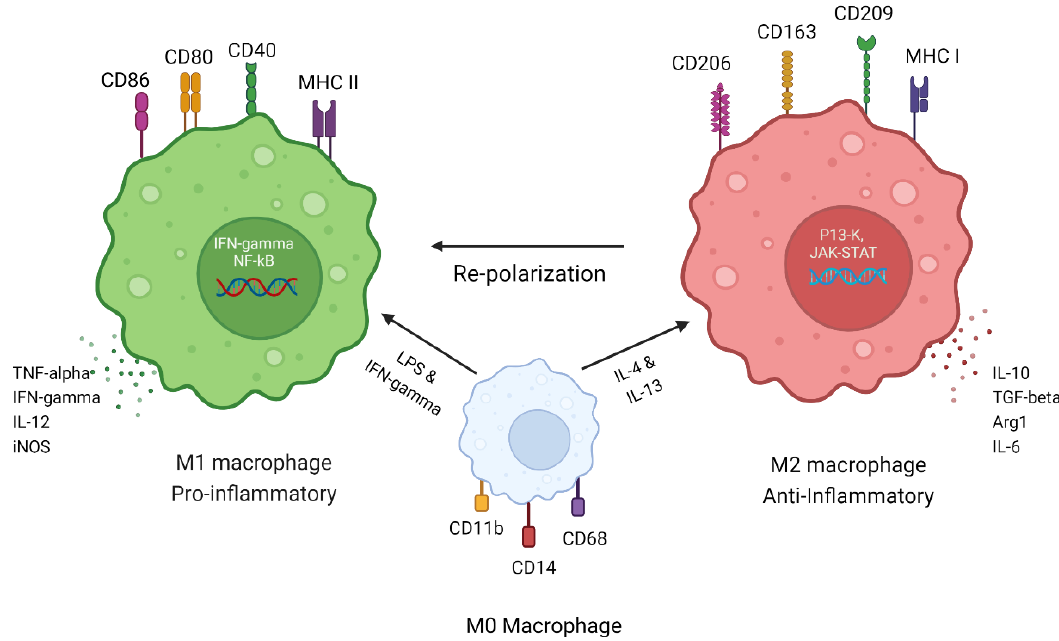
Figure 1. Macrophage plasticity. Macrophage states under different stimuli. Monocyte-derived M0 macrophages have CD11b, CD14, and CD68 as their surface markers. The stimulation of M0 macrophages with LPS and IFN-gamma converts them to pro-inflammatory M1 macrophages, which express cell surface receptors such as CD86, CD80, CD40, and MHC class II. M1 macrophage secretes pro-inflammatory cytokines such as TNF-alpha, IFN-gamma, IL-12, and iNOS. M1 macrophages have IFN-gamma signaling and NF-kB signaling, which stimulates them and preserves the M1 phenotype. M0 converts to M2 macrophages after stimulation with anti-inflammatory cytokines such as IL-4 and IL-13 and expresses cell receptor markers CD206, CD163, CD209, and MHC class I. M2 macrophages secrete anti-inflammatory cytokines such as IL-10, TGF-beta, Arg-1, and IL-6. M2 macrophages function through P13-K and JAK-STAT pathways and maintain their M2/TAM phenotype. Macrophage function varies with different stimuli and can perform anti-tumor (M1) or tumor-supportive (M2) functions. Adapted from “Immune Therapy in Multiple Myeloma”, by BioRender.com (2023). Retrieved from https://app.biorender.com/biorender-templates (accessed on 30 January 2023).